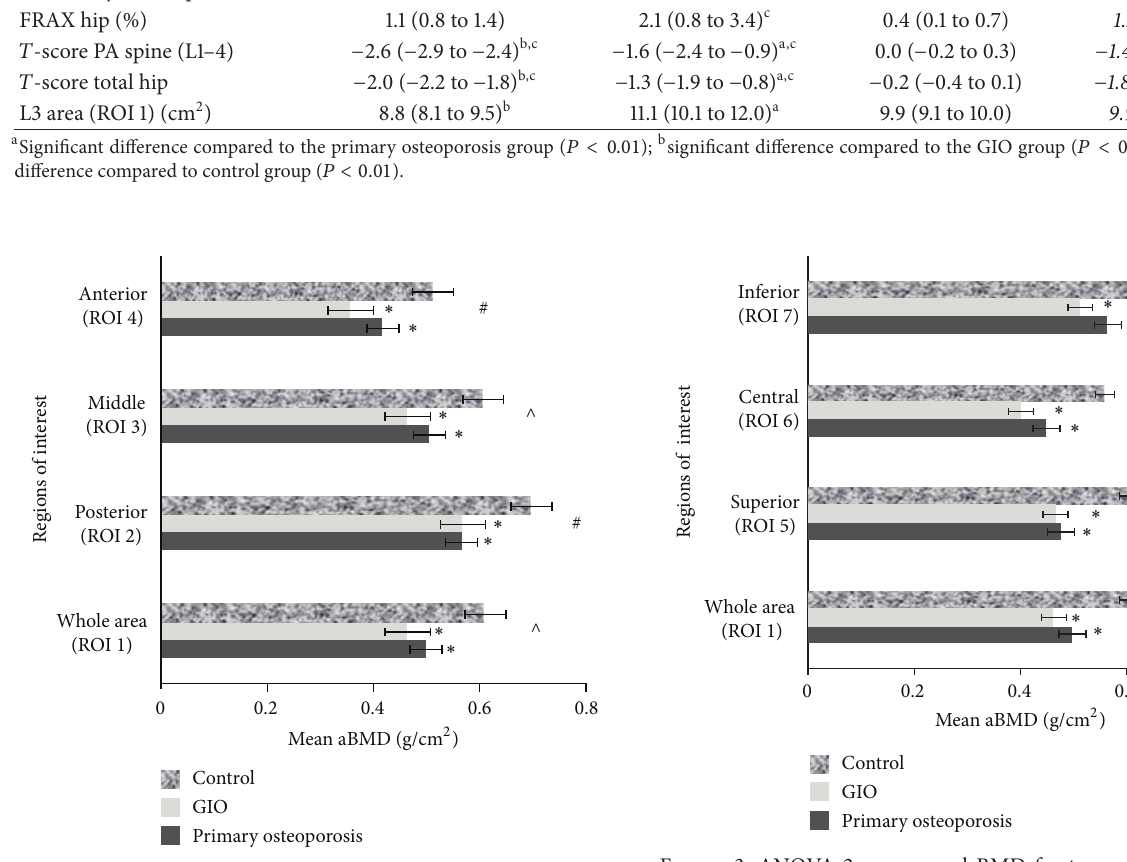
Figure 3: ANOVA 2, mean areal BMD for transverse regions of interest between groups, adjusted for ROI 1 area. Error bars are SEM. ∗ Significantly different to controls ( 𝑃 < 0.0001 ). # Significantly dif- ferent compared to all other ROIs. ∧ Significantly different to ROIs 6 and